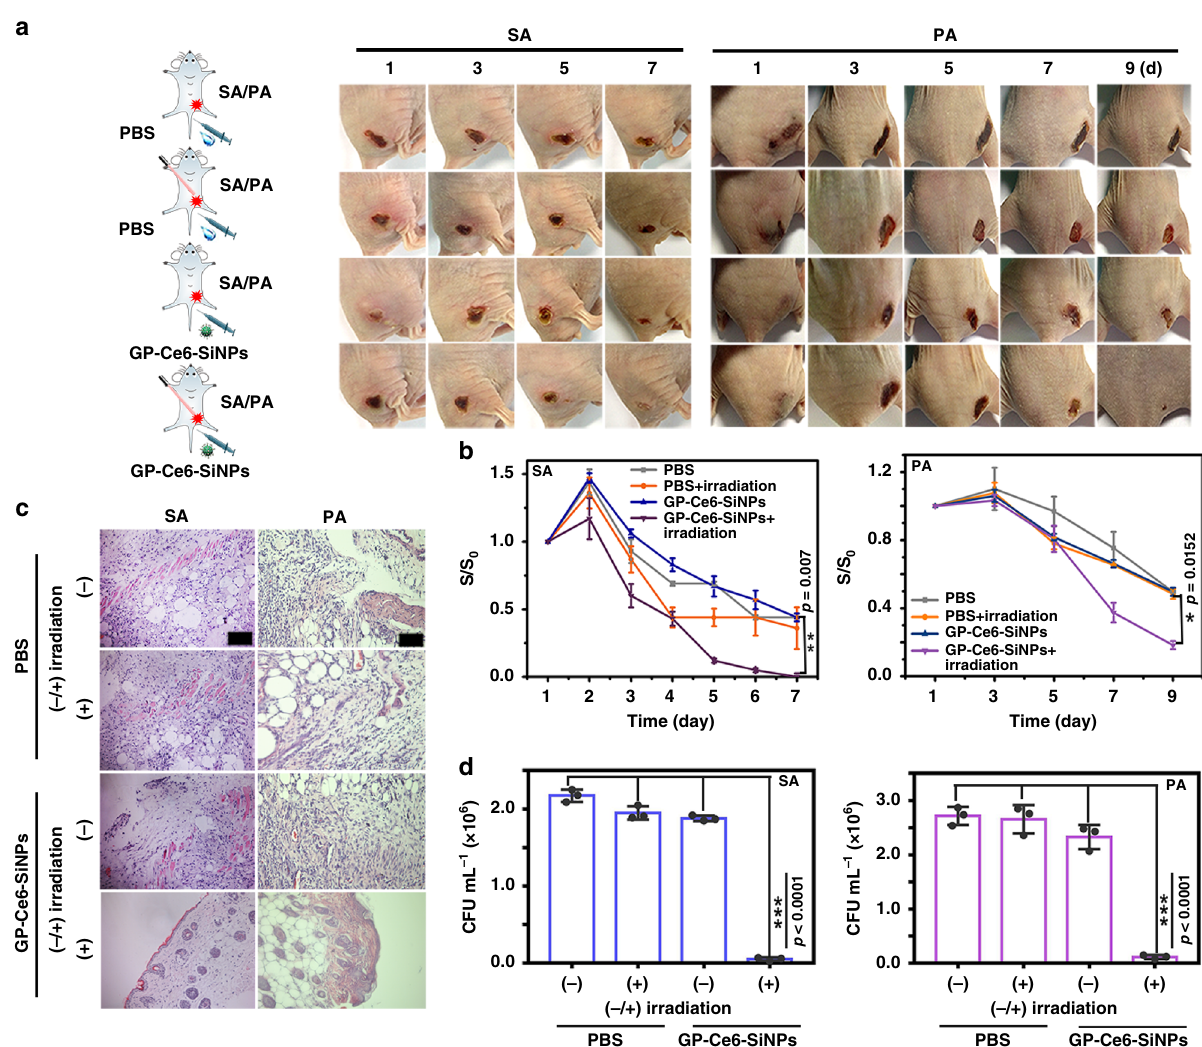
Fig. 6 In vivo antibacterial activity of GP-Ce6-SiNPs. a Representative photographs of time-dependent of SA- and PA-infected mice injected with GP-Ce6- SiNPs or PBS treated with or without light irradiation (660 nm, 12 mW cm − 2 ) for constant 40 min. The cartoons are created by Dr. Houyu Wang. b Corresponding time-dependent relative wound area (S/S 0 ) of SA- and PA-infected mice in panel ( a ). S 0 stands for the size of infection site at 1-day treatment and S stands for the size of infection site at n -day treatment. Error bars represent the standard deviation obtained from three independent measurements. c Corresponding histological images of the SA- and PA-infected skin tissues of mice in panel ( a ) at the 7th (SA) and 9th day (PA) post injection. Scale bar: 100 μ m. d Bacterial counts (CFU mL − 1 ) excised from the SA- and PA-infected tissues of mice at the 7th (SA) and 9th (PA) day post injection. Statistical analysis was performed using a one-way ANOVA analysis. Error bars represent the standard deviation obtained from three independent measurements (* p < 0.05, ** p < 0.01, *** p < 0.001, n = 3). The concentration of GP-Ce6-SiNPs is 10 mg mL − 1 (3.6 mg mL − 1 of GP and 100 μ g mL − 1 of Ce6). Typically, the number ( n ) of mice used per experiment is 3, the total number is 24, and the gender of mice is female. Source data